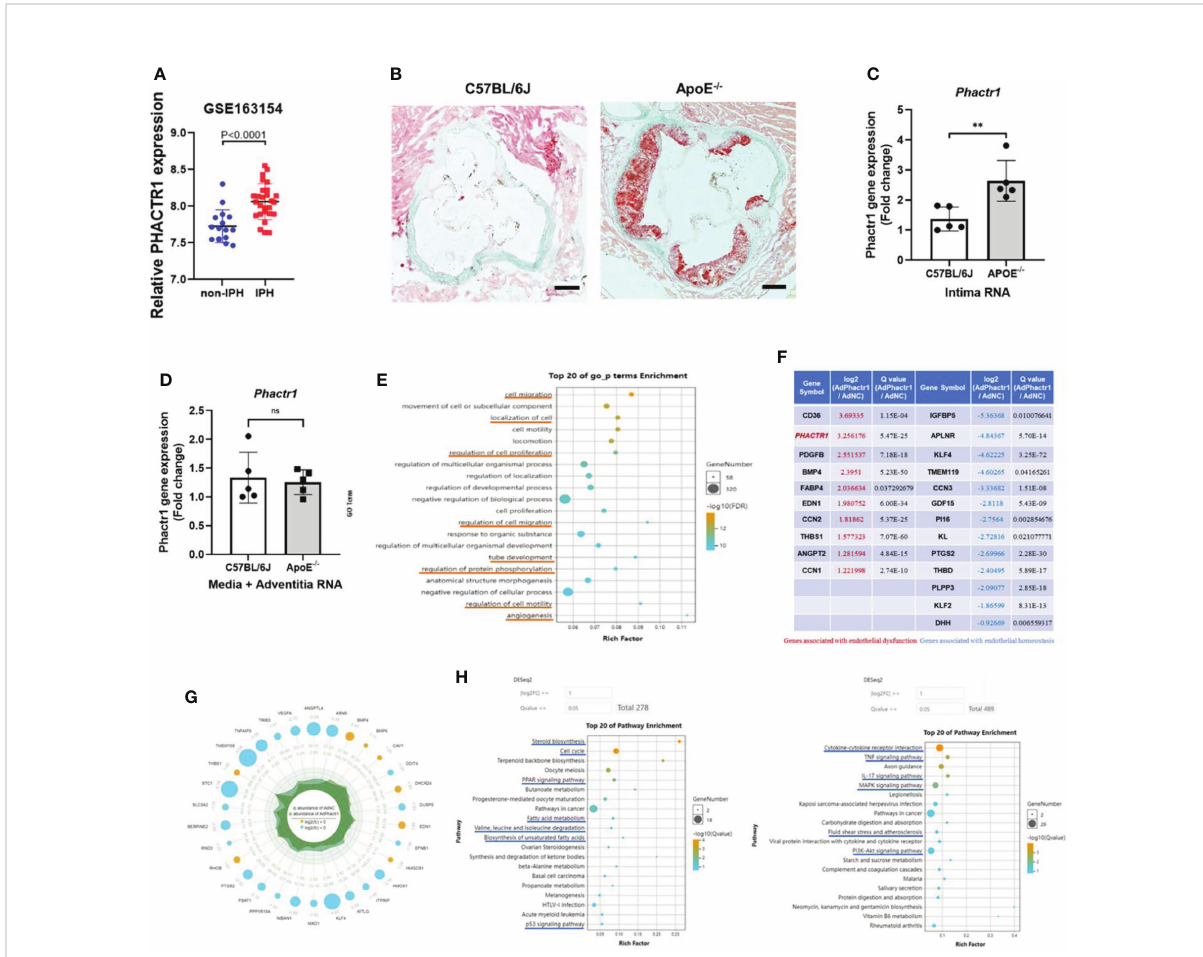
FIGURE 1 PHACTR1 is an important CAD risk gene that mediates endothelial dysfunction. (A) Expression of PHACTR1 mRNA levels in unstable plaques/ intraplaque hemorrhage (IPH) (n = 27) and stable plaques (non-IPH, n = 16) from human plaques mined from GSE163154. (B) Oil Red O staining of lesions of the aortic root in male ApoE-/-mice following 6 weeks of western diet and male C57BL/6J WT mice fed with normal chow diet, n = 5. Scale bar = 200 m m. (C) Phactr1 gene expression in vascular intimal lysate of ApoE-/- mice compared with C57BL/6J WT mice (n = 5 mice per group), **P < 0.01. (D) Phactr1 gene expression in vascular media and adventitia of ApoE-/- mice compared with C57BL/6J WT mice (n = 5 mice per group) ns, non-signi fi cant. (E) Top 20 GO_p terms enrichment of Ad-PHACTR1-treated endothelial cells revealed by transcriptomic pro fi ling. (F) Impact of PHACTR1 overexpression on selected expression of genes relevant to endothelial function dysfunction by transcriptomic pro fi ling. (G) Differential genes with top 30 P value of Ad-PHACTR1-treated endothelial cells. (H) Top 20 KEGG upregulated or downregulated pathways enriched in Ad-PHACTR1-treated endothelial